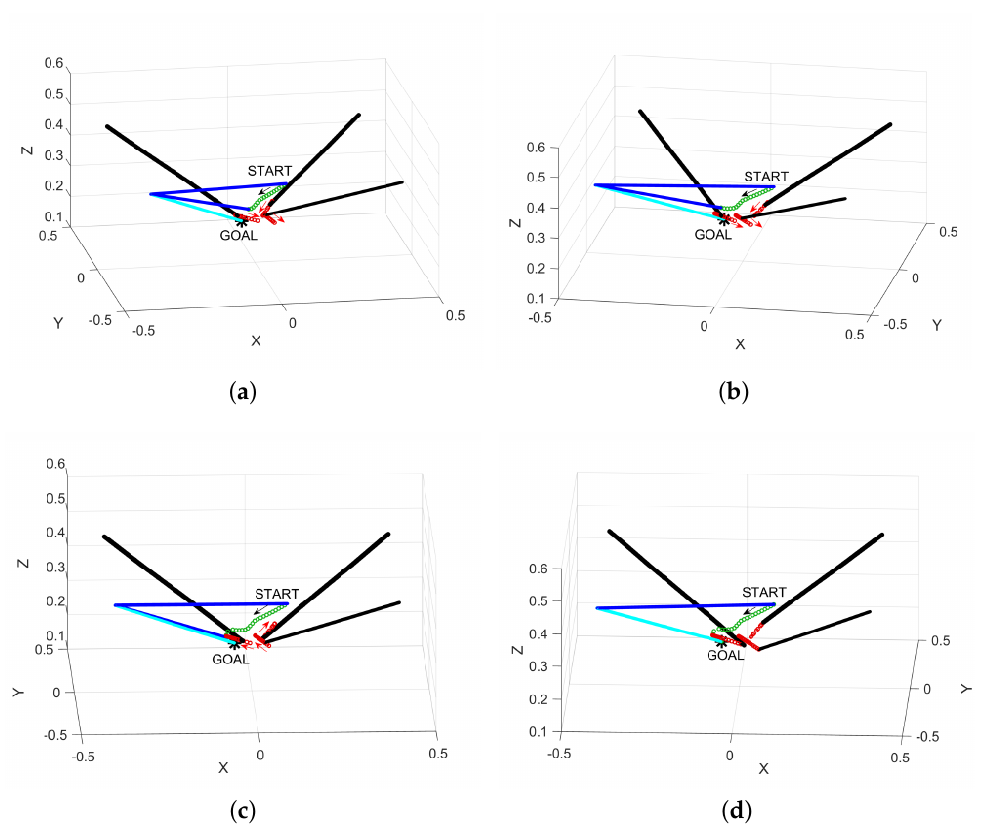
Figure 7. In blue, the starting position and the position in the snapshot of the robot, while in light-blue, the goal pose. In black, the obstacle. In red, the trajectory of the obstacle tip. In green, the real trajectory of the EE. The black arrows show the direction of the movement of the obstacle tip in that snapshot. ( a ) First snapshot; ( b ) second snapshot; ( c ) third snapshot; ( d ) final